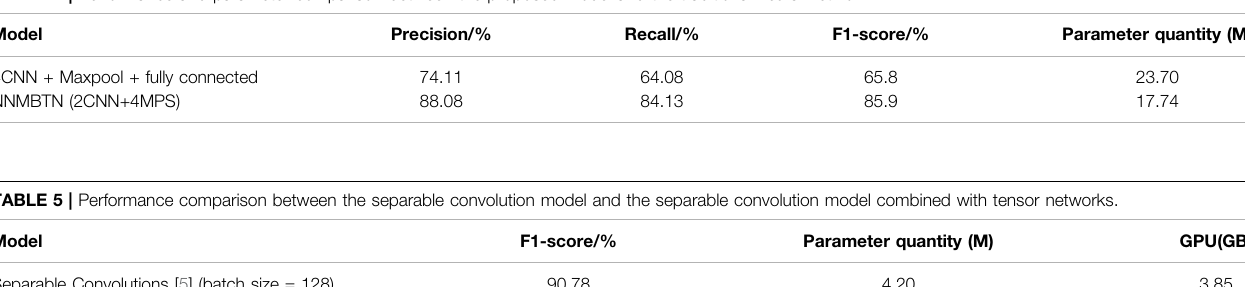
TABLE 4 | Performance and parameter comparison between the proposed model and the traditional neural network.